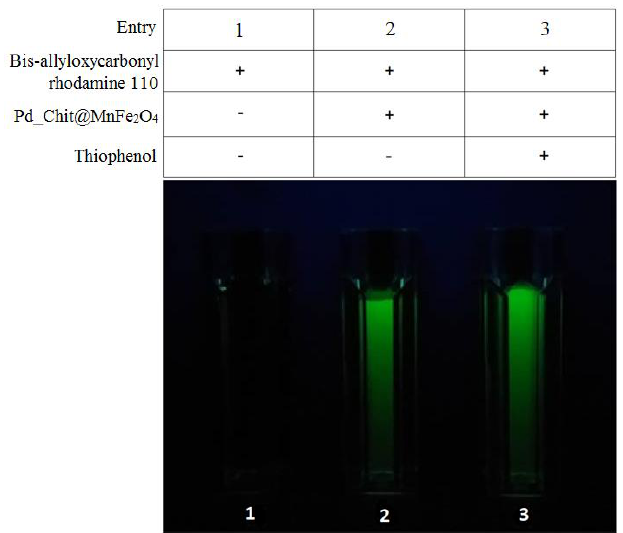
Figure 7. Deprotection of bis-allyloxycarbonyl rhodamine 110 in 3 different conditions.